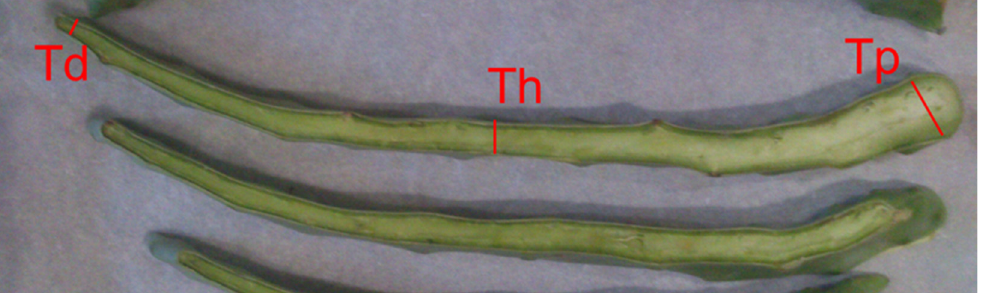
Figure 2. Straps made from the cutting of prickly-pear cladodes. Td = thickness of the proximal extreme of the strap; Tp = thickness of the distal extreme of the strap; Th = thickness at half-length. For the estimation of the exposed surface area when cutting the cladode into cubes, each one of the exposed faces of the cube was considered as a trapezoid. The total cladode exposed surface was estimated, as shown in Equation (3):